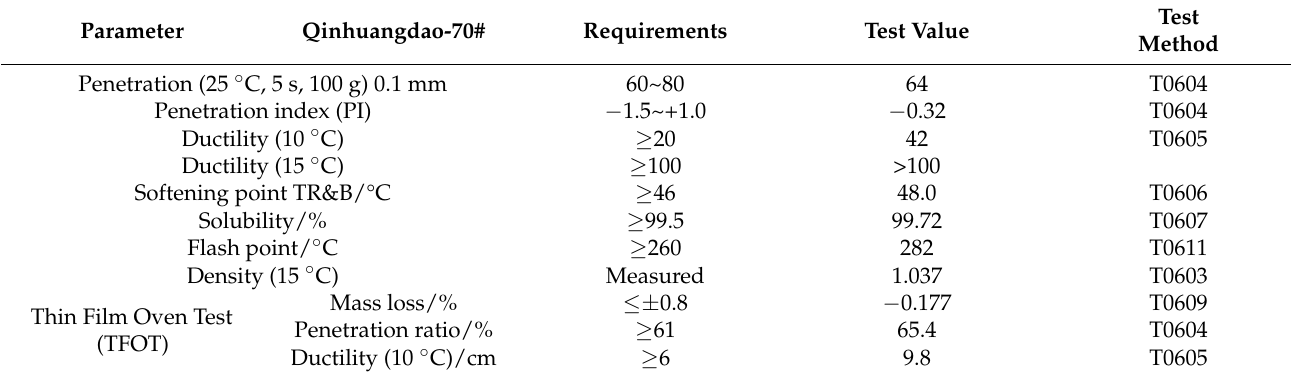
Table 1. The properties of asphalt binders.